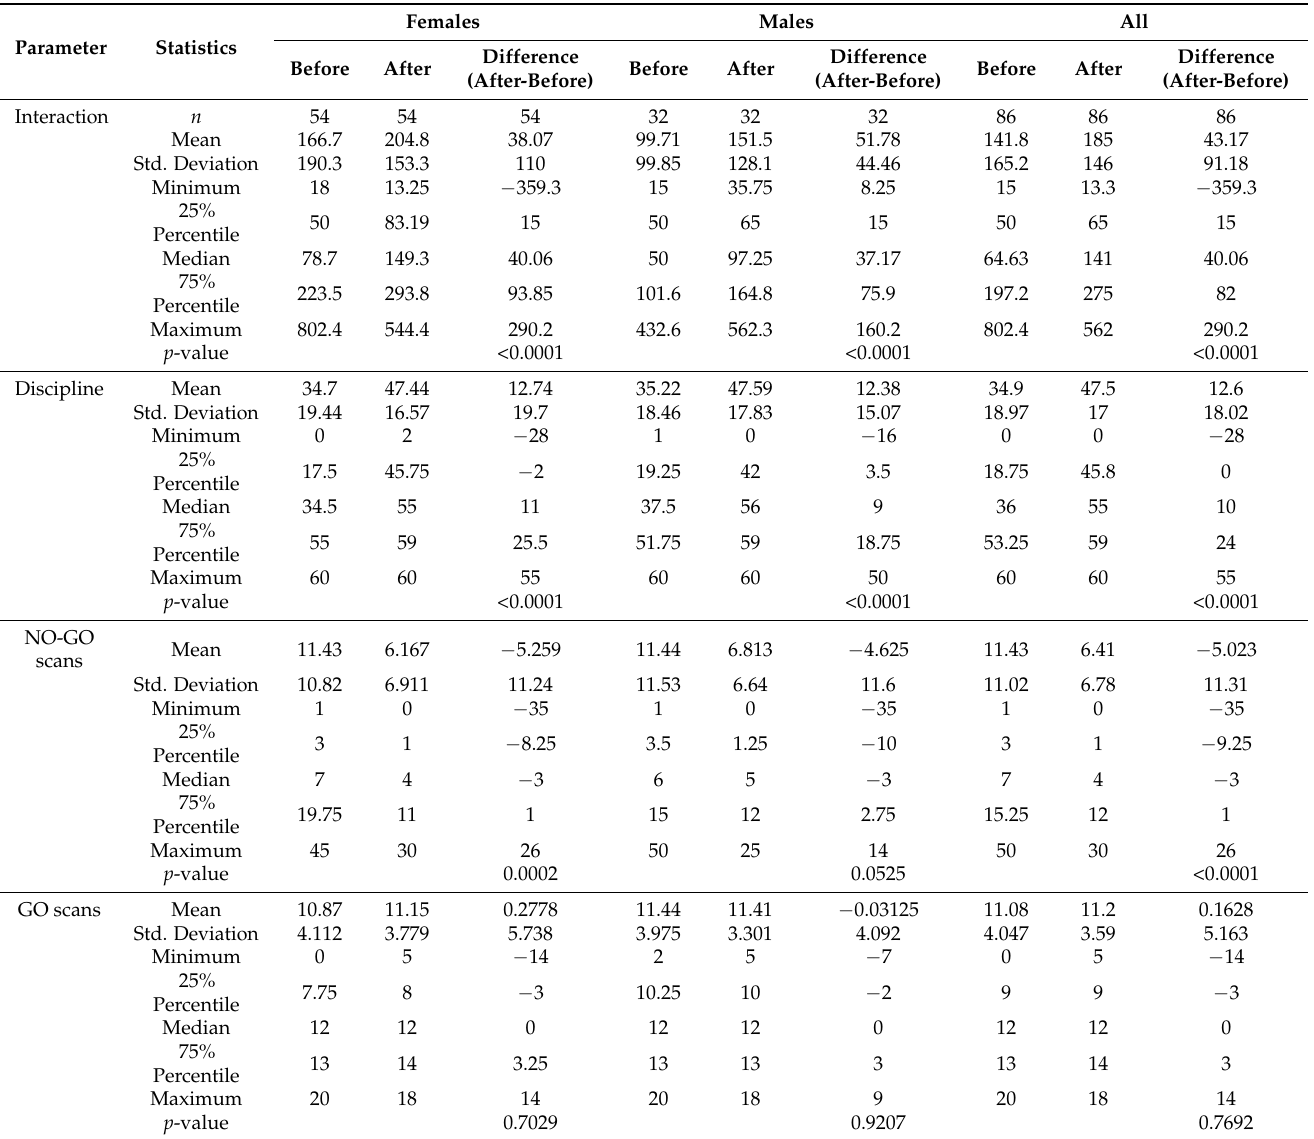
Table 2. The influence of gender and differences in individual parameters before vs after the AI update and their statistical significance (evaluated by Wilcoxon signed-rank